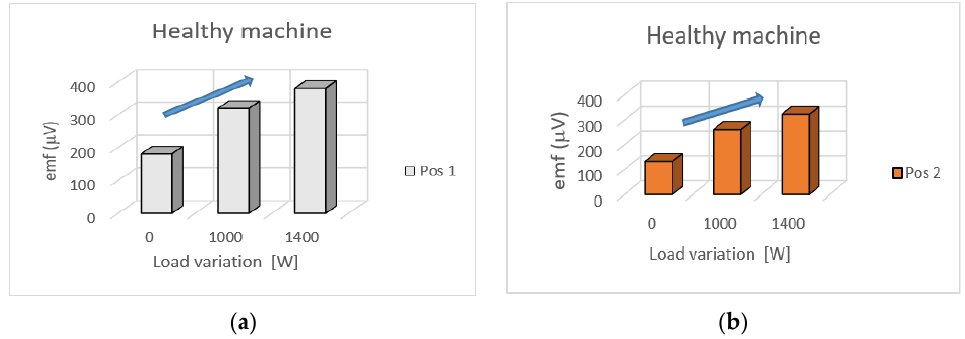
Figure 10. Harmonic components at 850 Hz under both measurement positions for healthy motor and load variation ( a ) measurement in position 1, ( b ) measurement in position 2.